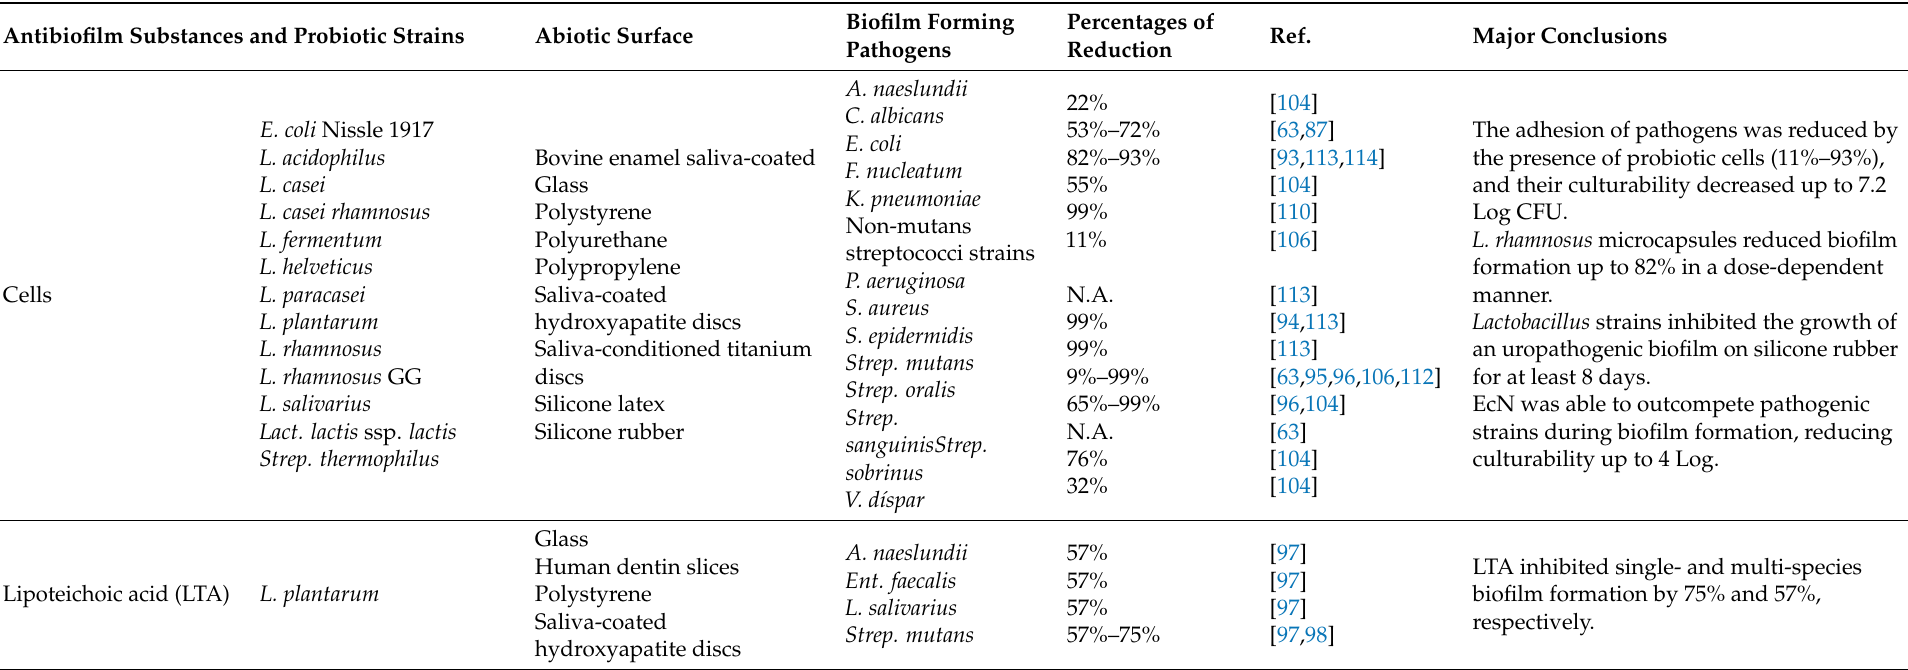
Abbreviations: CFS, Cell-Free Supernatant; CFU, Colony-Forming Units; EcN, E. coli Nissle 1917; EPS, Exopolysaccharides; PVC, Polyvinyl Chloride; N.A., Not Available. Ac ., Acinetobacter ; A ., Actinomyces ; Bac ., Bacillus ; C ., Candida ; Ent ., Enterococcus ; E ., Escherichia ; F ., Fusobacterium ; K ., Klebsiella ; L ., Lactobacillus ; Lact ., Lactococcus ; Lis ., Listeria ; P ., Pseudomonas ; Ser ., Serratia ; S ., Staphylococcus ; Strep ., Streptococcus ; V ., Veillonella